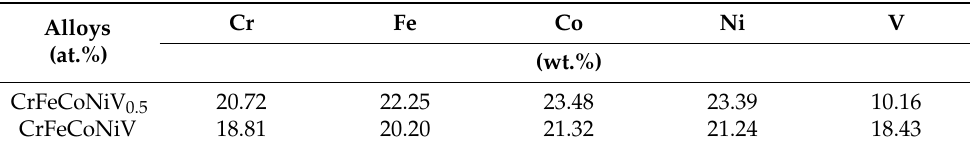
Table 1. Nominal compositions of CrFeCoNiV x